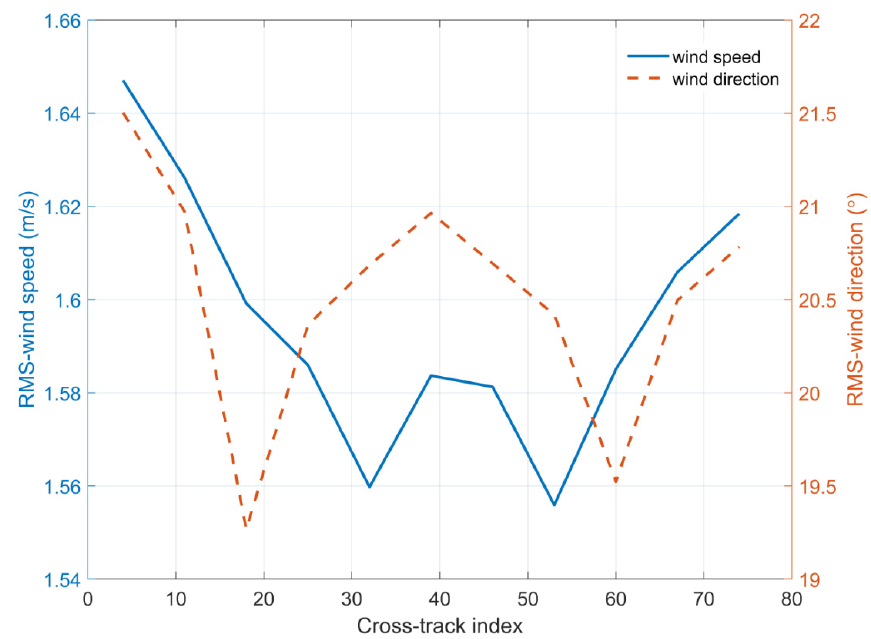
Figure 13. RMS of HY-2B-ECMWF wind vector versus cross-track index. The solid and dashed lines represent the results of wind speed and wind direction, respectively.